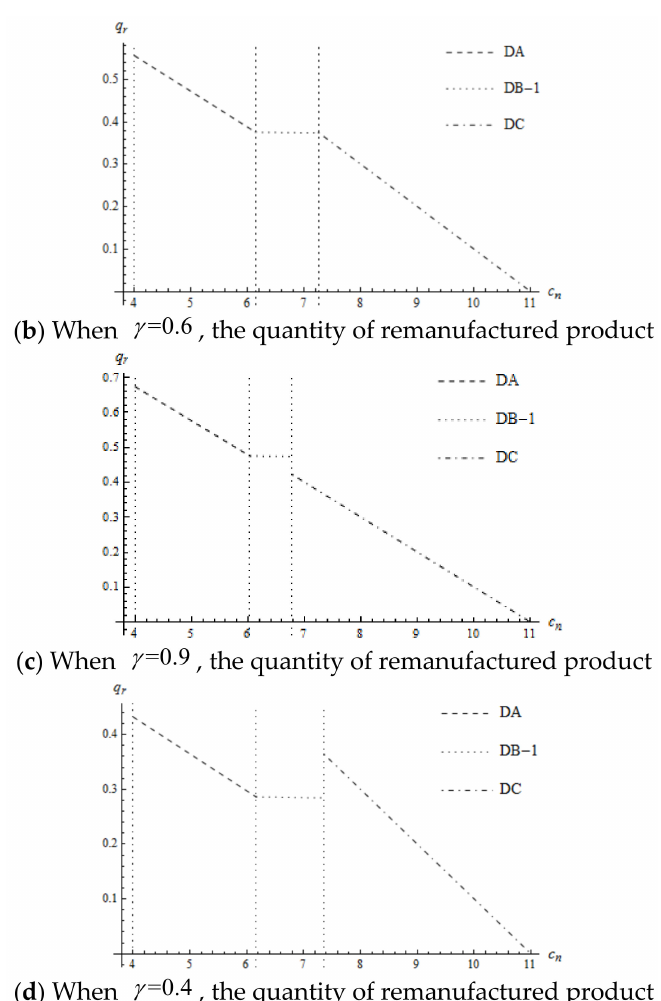
Figure 4. The impact of c n on the manufacturer’s production decision under high mandated remanufacturing target.